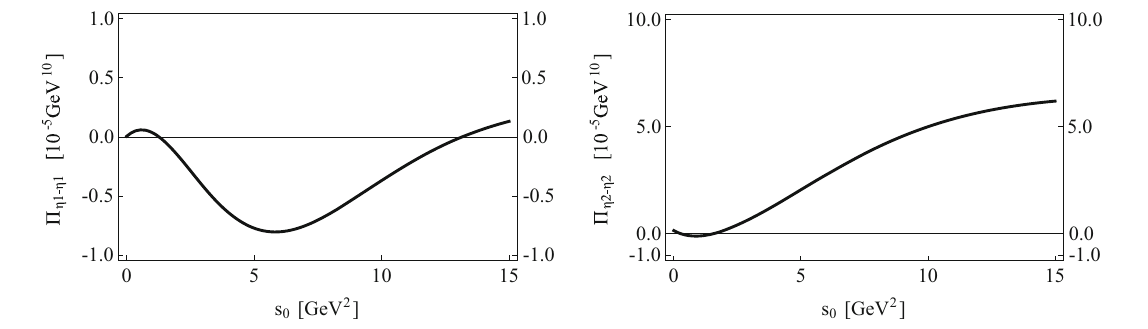
(cid:4) (cid:5) , s ( M 2 , s ) as functions of the threshold value s M 2 and Π η 0 0 B B 1 η 1 2 η 2